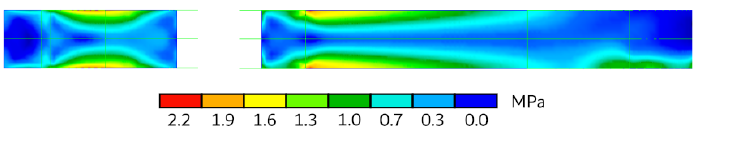
Figure 20. Von Mises stresses distribution in the lateral surfaces of the support ( left ) and of the arm ( right